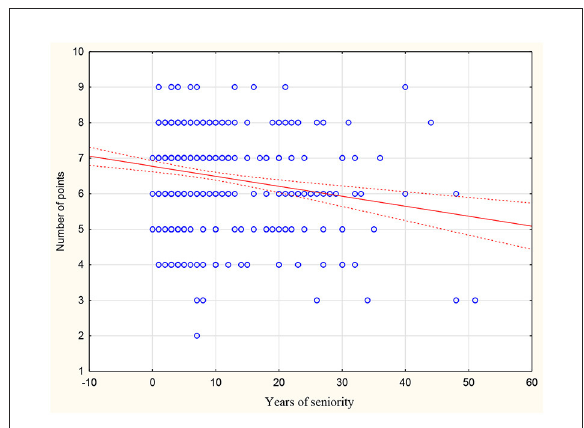
FIGURE2 Correlation between years of seniority and scores on the CKD knowledge assessment test.